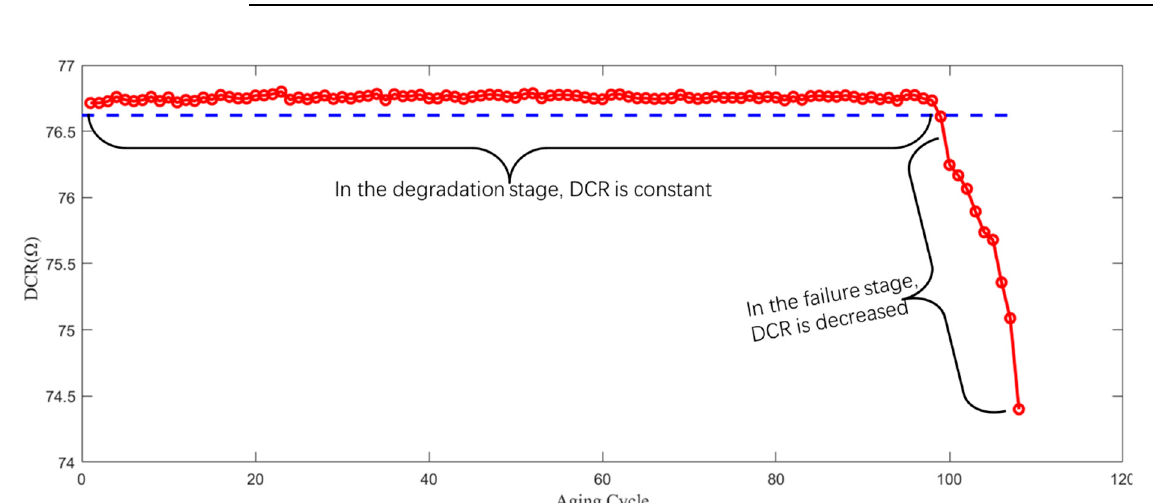
Table 1. Part of direct-current resistance (DCR) collected by LCR meter.